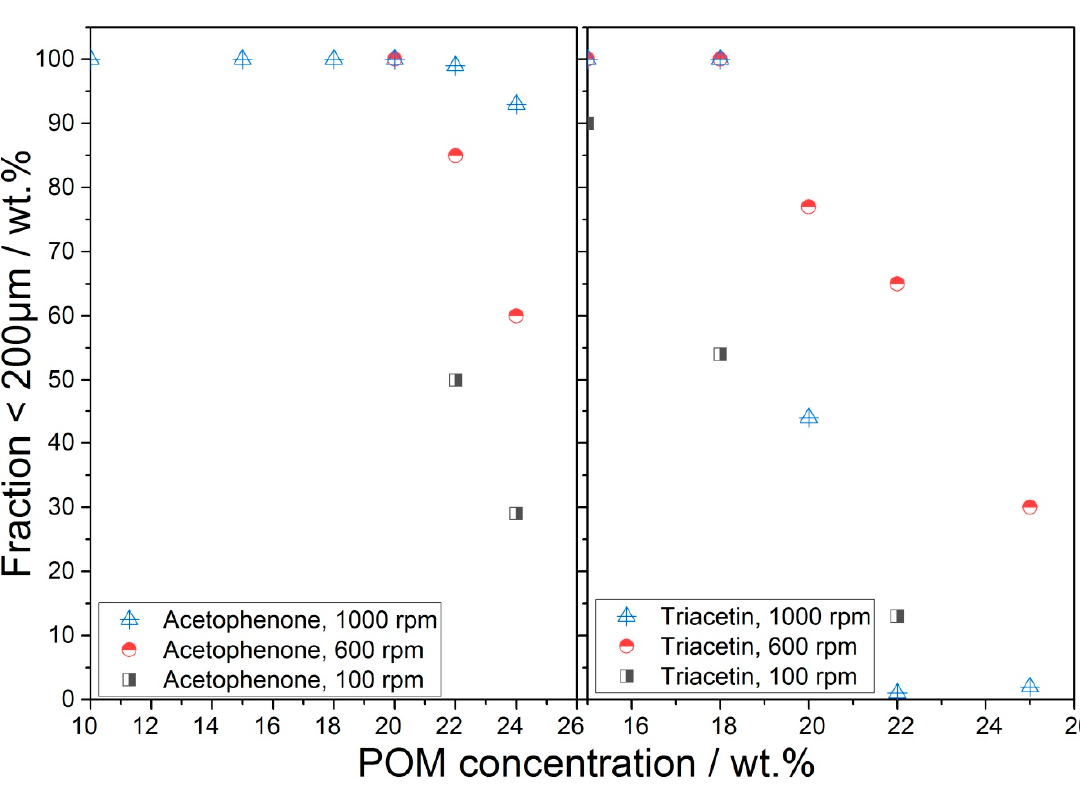
Figure A1. Yield of the particle fraction smaller than 200 µ m for POM powders obtained from acetophenone (left) and triacetin (right) for varying initial POM concentrations and stirring speeds of 100 rpm, 600 rpm, and 1000 rpm. Since higher POM concentrations increased the overall yield of feedstock material, we aimed at high initial POM concentrations. However, if the formed particles became too large, application in PBF was impractical. Therefore, a cut size of 200 µ m was chosen. Depending on the stirring conditions, the yield of particles below 200 µ m varied greatly. Based on this evaluation, 20 wt.% and 22 wt.% POM in acetophenone with a stirring speed of 1000 rpm appeared favorable. For triacetin, the yield for 18 wt.% was nearly 100% for 1000 rpm and 600 rpm, while for 20 wt.%, it was already below 80% for 600 rpm and even below 50% for 1000 rpm. Consequently, POM concentrations of 18 wt.% and 20 wt.% with a stirring speed of 600 rpm were selected for further